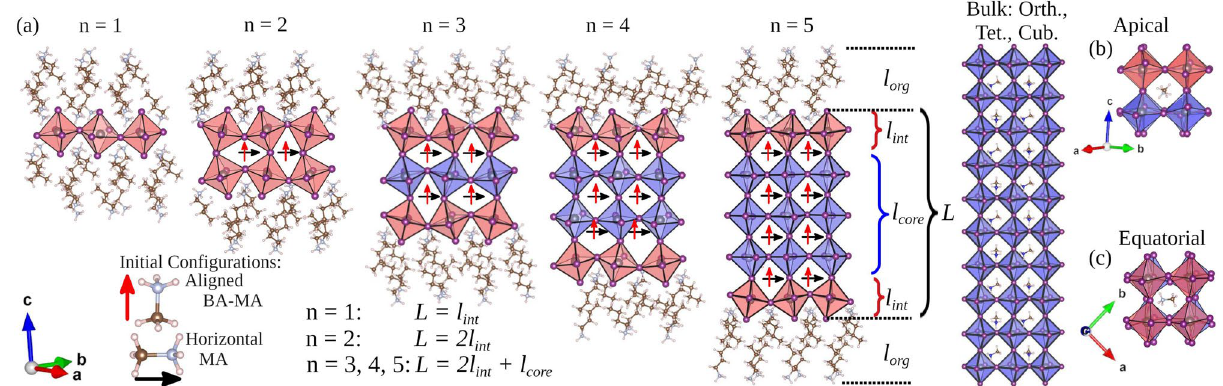
Figure 1. ( a ) Representation of BA 2 MA n − 1 Pb n I 3 n + 1 2D-RP perovskites with n = 1, 2, 3, 4, 5, and ∞ (orthorhombic, tetragonal, and cubic bulks). l org depicts the thickness of the BA cation-spaced region, where L is the inorganic layer thickness defined by l int and l core as interface and core octahedrons, respectively. The representations define the initial configurations based on MA horizontal-like (black arrow “ → ”) and BA-MA aligned-like (red arrow “ ↑ ”), whereas the cubic and tetragonal configurations were considered for the bulks (n = ∞ ). All 2D and 3D perovskites were structurally analyzed considering apical ( b ) and equatorial ( c ) orientations separately.